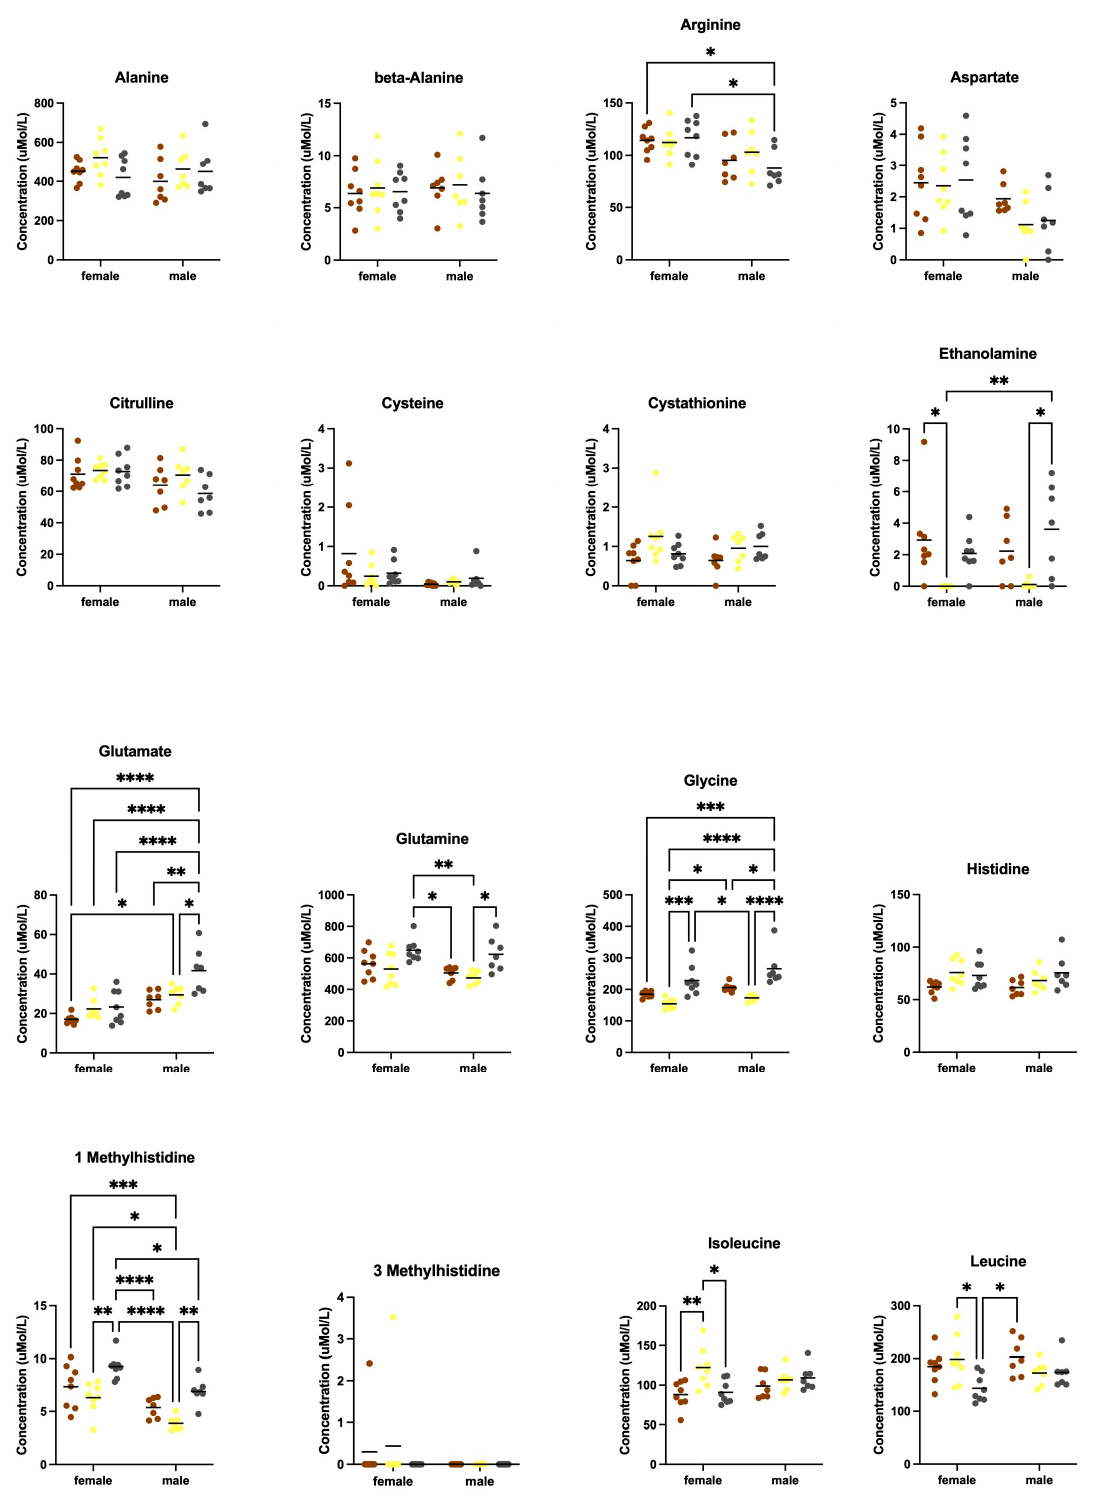
Figure 6. Blood plasma amino acid levels as an effect of diet. Blood was collected from male and female C57BL/6J mice at euthanization and quantitated for plasma amino acids by ion-exchange chromatography as an effect of diet (Teklad 2019, AIN-76A or Purina 5015). Statistics were determined by 2-way ANOVA and Tukey’s multiple comparison tests (see Table S1) denoted by p < 0.05 (*), p < 0.01 (**), p < 0.001 (***) and p < 0.0001 (****). See Figure 7 for remaining data.